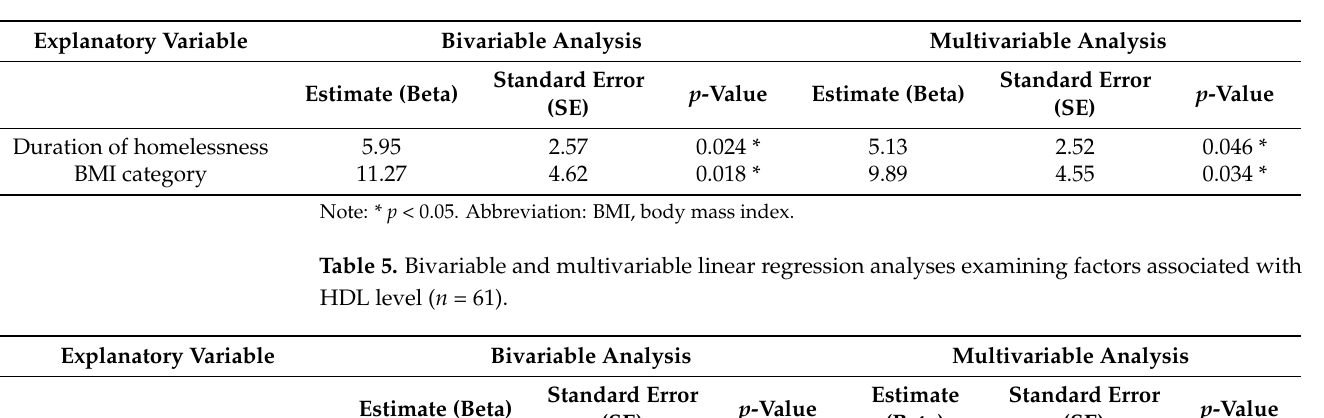
Table 4. Bivariable and multivariable linear regression analyses examining factors associated with LDL level ( n = 61).